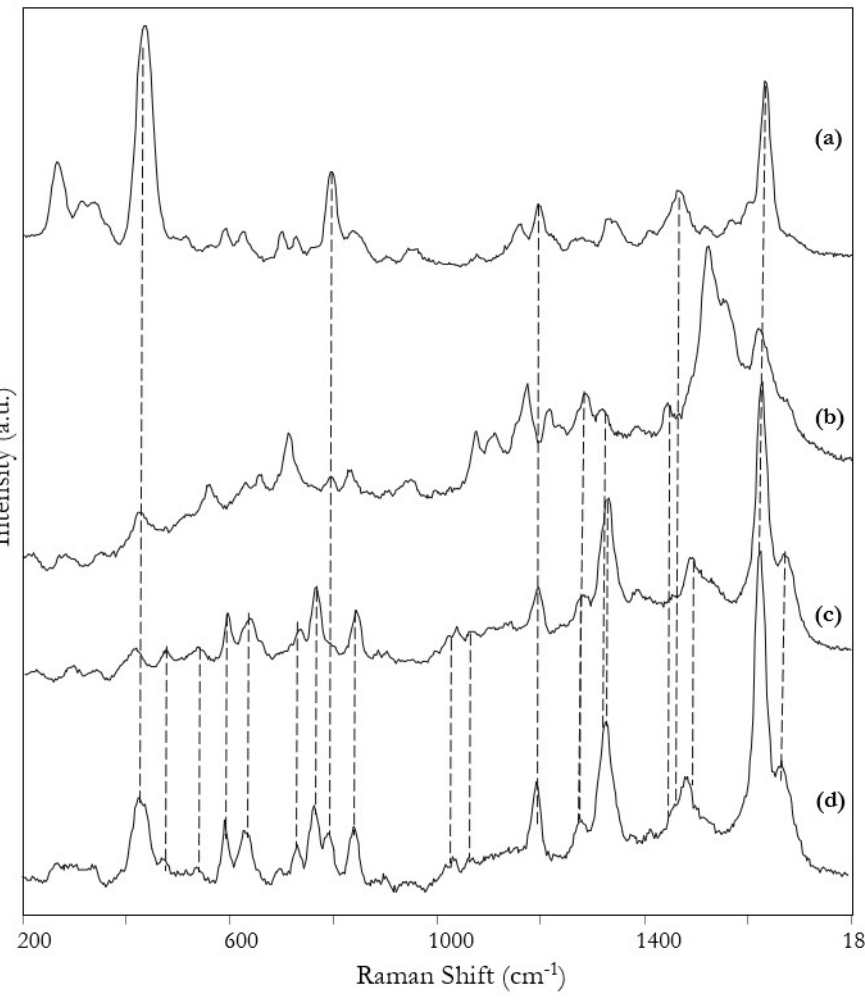
Figure 3. SERS spectra of ( a ) cyan, ( b ) yellow, ( c ) magenta, and ( d ) a mixture 1:1:1 of the three dyes. Spectra were obtained from 10 mM ethanolic solutions. Table 1. Tentative assignment of Raman and SERS bands for the reference dyes magenta, yellow, and cyan.